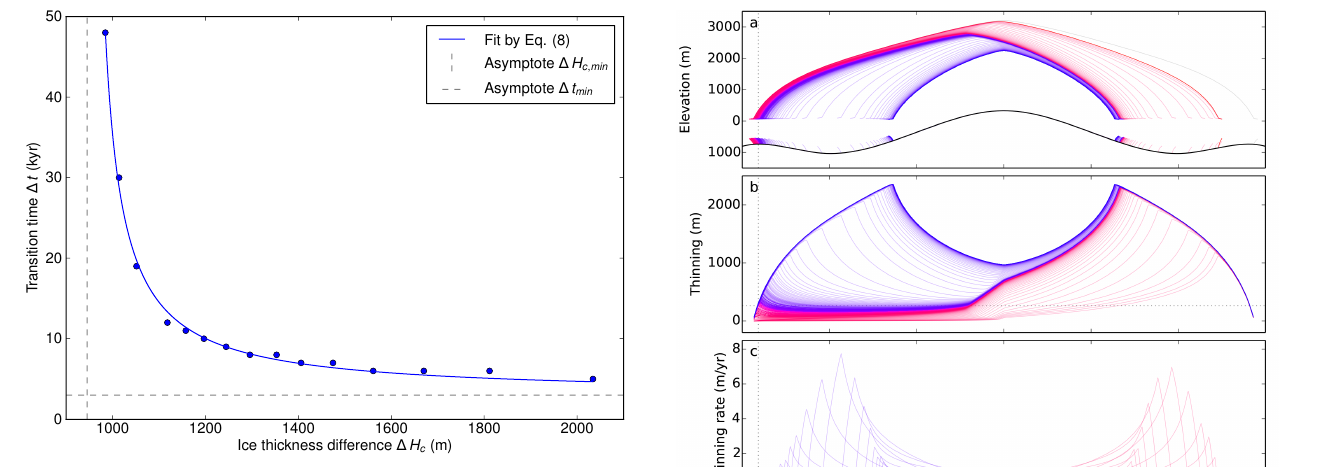
Figure 9. Transition time of MISI (cid:49)t plotted against central ice thickness difference between initial and final steady states of the ice sheet (cid:49)H c . Each dot represents a simulation of scenario U with a different central bed elevation b c . The constants for the fit by Eq. (8) are (cid:49)t min = 3000yr, (cid:49)H c , min = 945m and C = 1727yrm. of lengths L 0 and L 1 , respectively,